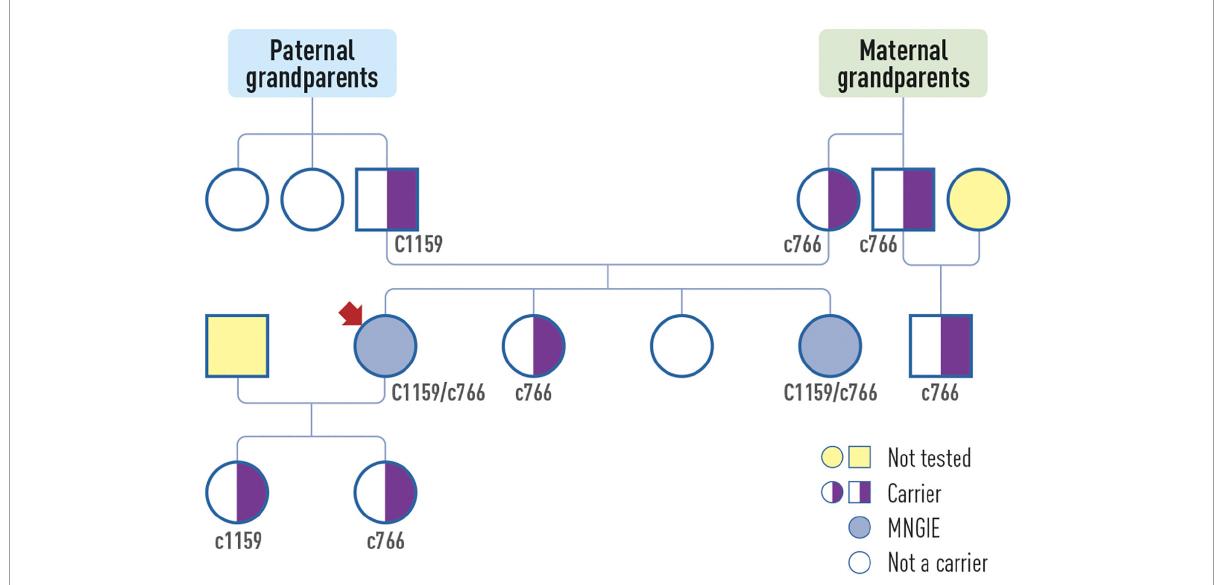
FIGURE2 The patient’s (arrow)